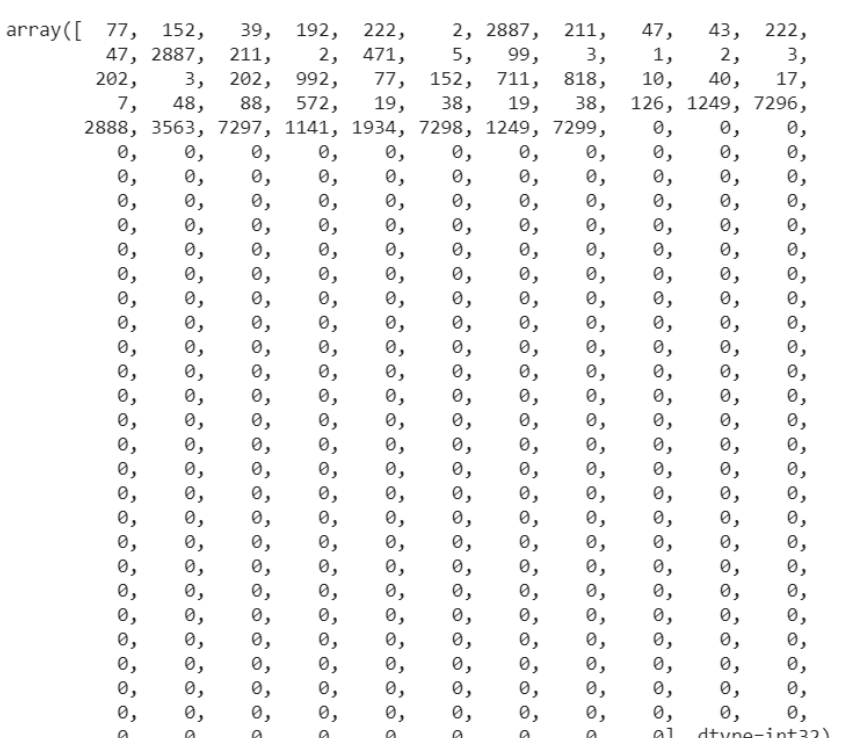
The output layer of each deep learning model consisted of Instagram posts CI – zeros and ones. Having that in mind, the output layer of Instagram posts dataset in 2019 and 2020 have a vector with a size of 2834 and 6919,